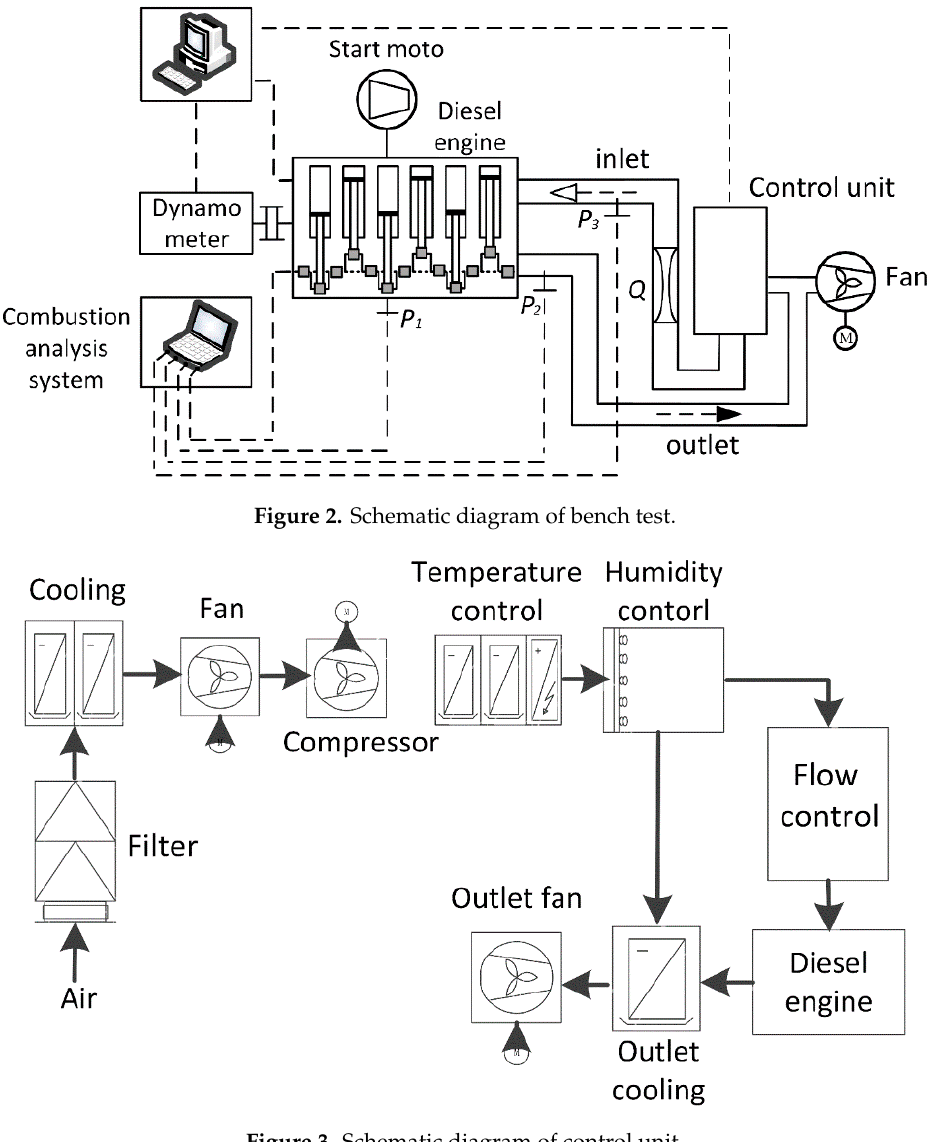
Figure 3. Schematic diagram of control unit. Table 2. The accuracy and specification of each device.